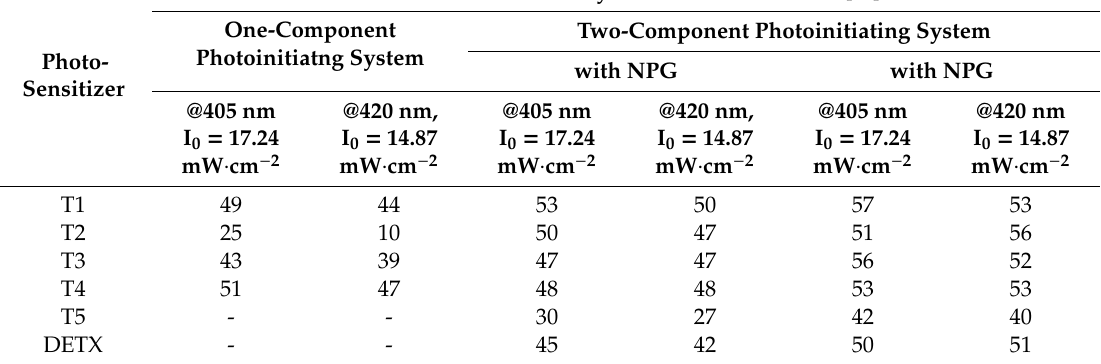
Table 5. Functional group conversions of acrylate monomer TMPTA using a photoinitiating systems based on 2,4-diethyl-thioxanthen-9-one derivatives alone (5.3 × 10 − 3 mol · dm − 3 , ~0.2% wt.) or